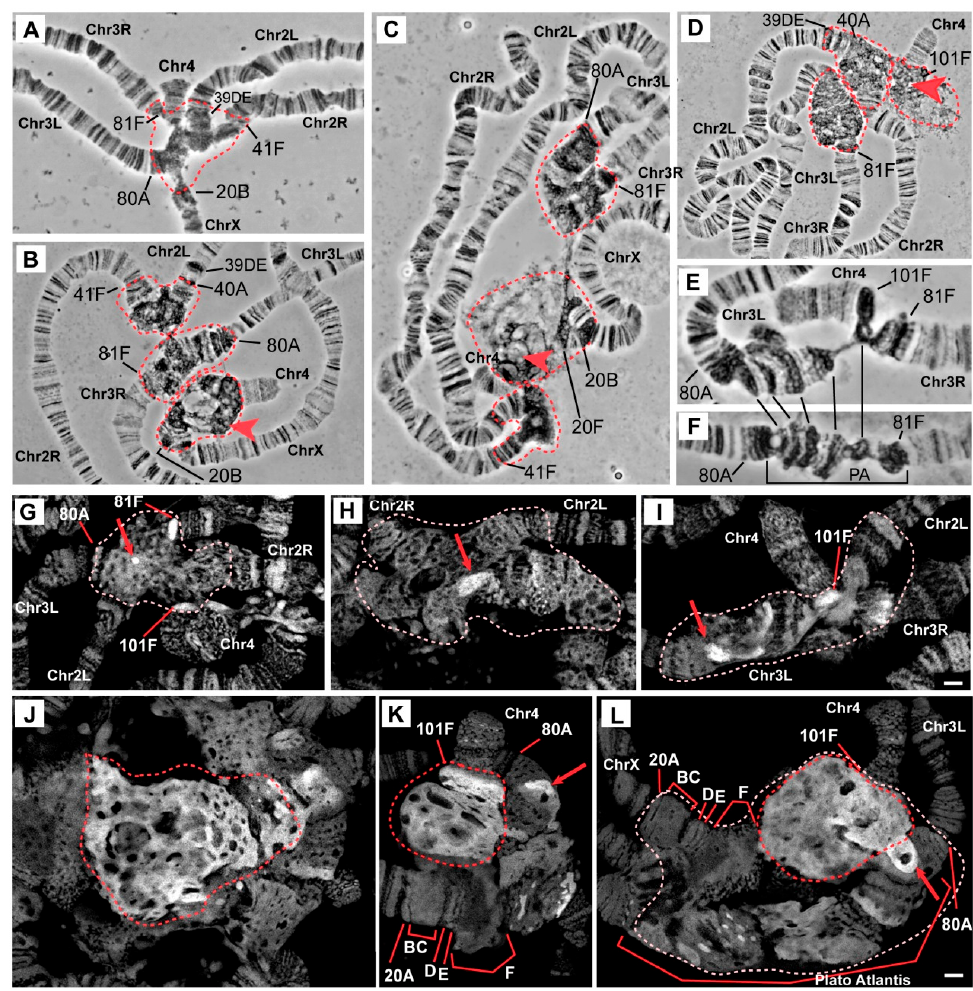
Figure 1. Morphological features of pericentromeric heterochromatin in the polytene chromosomes of Rif1 mutants. ( A – F ) Morphological analysis of the pericentromeric regions of the polytene chromosomes stained with aceto–orcein and examined in phase contrast. ( A ) Wild-type line; pericentromeric regions of all four chromosomes are indicated by a dashed circle. ( B , C ) Lines carrying null-allelic mutations in the Rif1 gene: Rif1 KO [31] ( B ) and Rif1 1 / Rif1 2 [27] ( C ); pericentromeric regions of chromosomes 2 and 3 and associations of chromosomes X and 4 are outlined by dashed lines separately. ( D ) Line Rif1 PP1 , which carries a directed mutation in the Rif1 gene that disrupts the binding site for phosphatase PP1 [27]; a red arrowhead in B-D point to a large block of new material appeared at the base of chromosome. ( E ) Pericentromeric region of chromosome 3 (Plato Atlantis) and chromosome 4 in the line with the Rif1 1 mutation [27]; ( F ) a pericentromeric region of chromosome 3 (Plato Atlantis) in the +/ Rif1 2 heterozygous larvae. Lines connect homologous regions of the 3 d chromosomes in ( E , F ) and illustrate the similarity of all morphological structures. ( G – L ) Optical sections of the pericentromeric regions of the polytene chromosomes stained with DAPI (super-resolution 3D-SIM). ( G ) Wild-type line; pericentromeric regions of all four chromosomes are outlined by a dashed line. ( H ) SuUR ES line; the dashed line delineates the pericentromeric regions of chromosomes 2 and 3. ( I ) The SuUR ES Su(var)3-9 06 line; the dashed line indicates the pericentromeric regions of chromosomes 2L, 3L, 3R and 4. ( J – L ) Pericentromeric heterochromatin in Rif1 1 / Rif1 2 mutants; a dashed line in J delineates a large block of DAPI-positive material; a dashed line in K delineates two discrete zones of DAPI-positive material at the base of chromosome 4; pericentromeric regions of chromosomes X, 3L, 3R and 4 are outlined by a dashed line in L. All visual fields inside polytene nuclei in panels ( G – L ) are presented at the same scale. Scale bar 2 µ